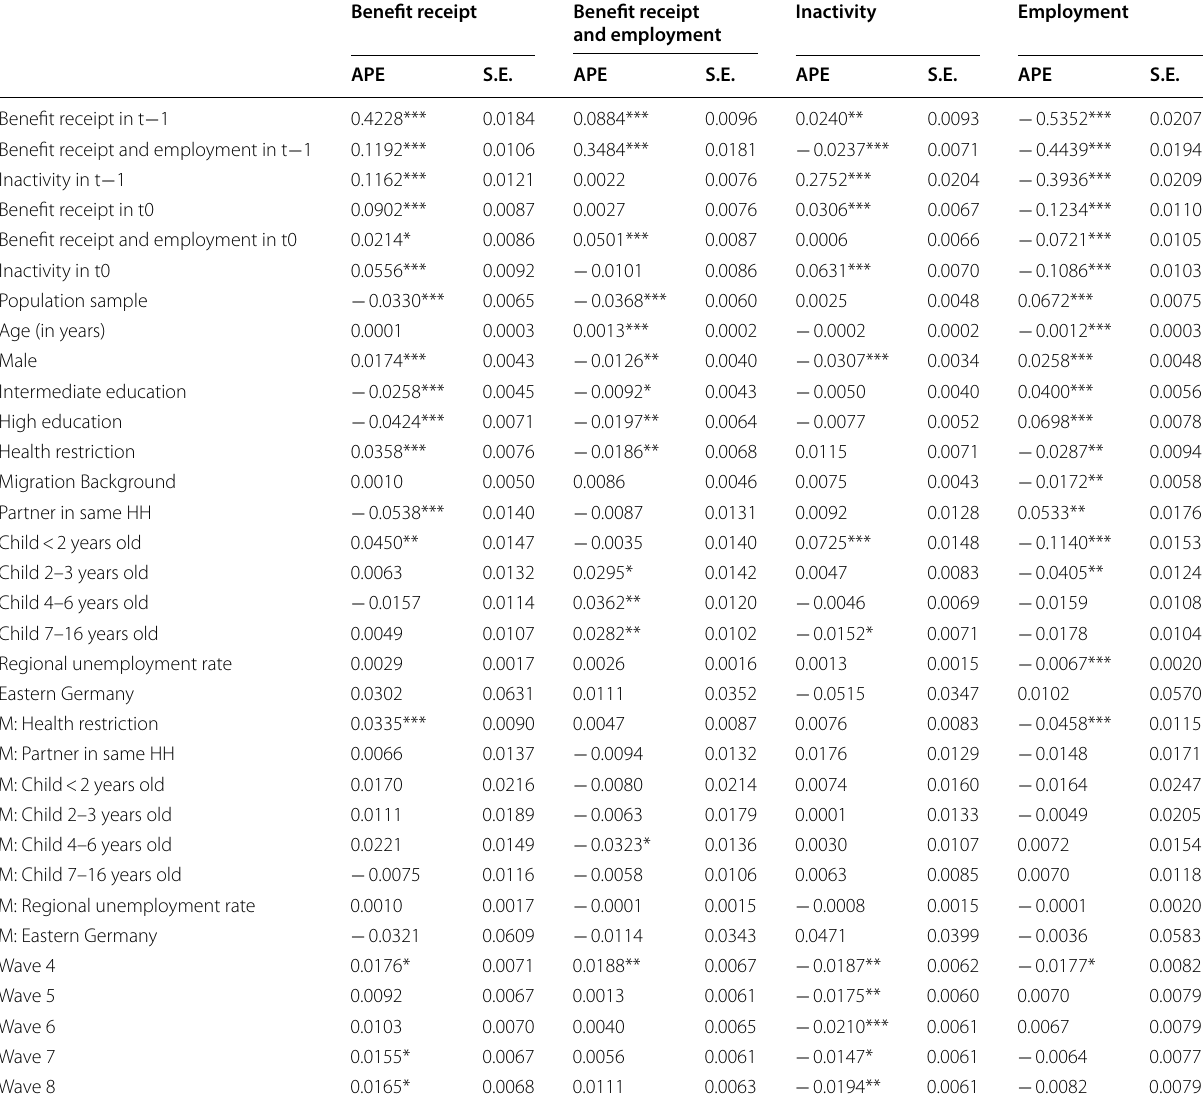
Table 13 Average partial effects of all explanatory variables on the probability to be in a given state in t